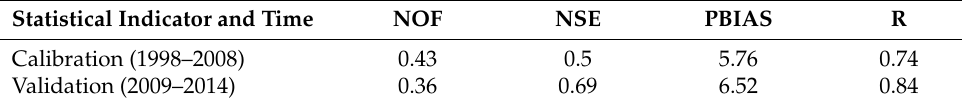
Table 5. HEC-HMS model performance at Pitebaddera hydrologic station.